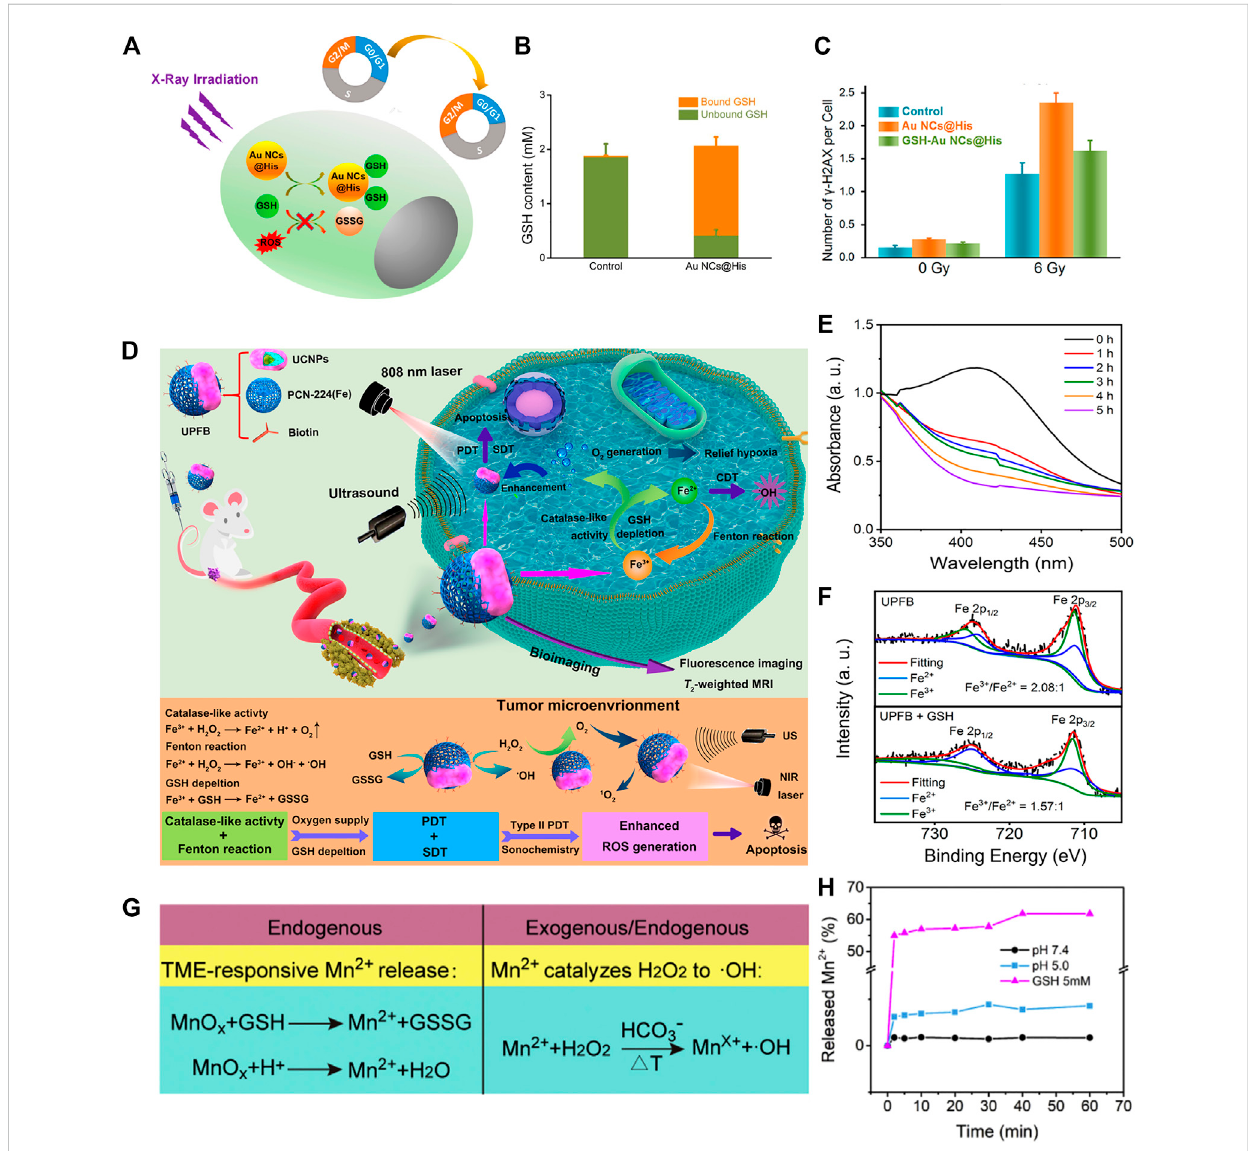
FIGURE 7 (A) Schematic illustration of GSH exhaustion-enhanced radiotherapy with the introduction of Au NCs@His. (B) GSH content in the cells without and with Au NCs@His treatment. (C) Comparison results of DNA damage molecular (named γ -H2AX) expression degree between Au NCs@His and GSH-Au NCs@His under different doses of radiation. Reproduced with permission. Copyright 2018 American Chemical Society. (D) Ampli fi ed effect of PDT, CDT, and SDT through GSH depletion and O 2 supplement for multimodal synergistic therapy. (E) GSH depletion ability of UPFB in different incubation time. Reproduced with permission. Copyright 2020 American Chemical Society. (F) The proportion of Fe 3+ /Fe 2+ in the presence or absence of GSH. (G) Different antitumormechanismsof MS-BSA rely on endogenous and exogenous factors. (H) Mn 2+ wasreleased from MS-BSA under reductive andacidic environments. Reproduced with permission. Copyright 2021